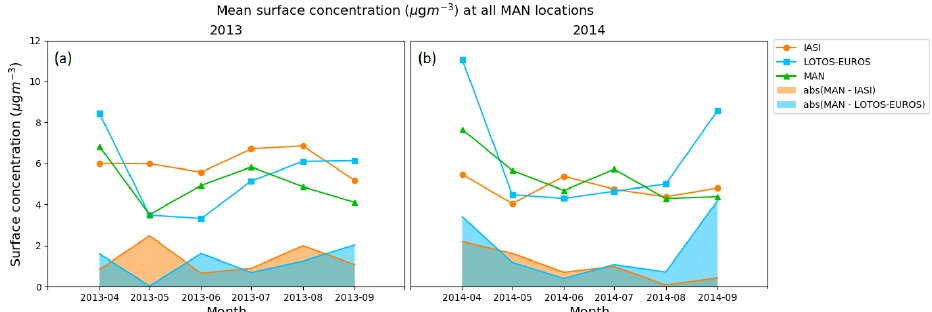
Figure 10. Mean of the NH 3 surface concentrations at all MAN locations per month (green line) and the coinciding NH 3 surface concen- trations from LOTOS-EUROS (blue line) and IASI (orange line) in 2013 (a) and 2014 (b) . The absolute differences between MAN and LOTOS-EUROS are shown in blue and the absolute differences between MAN and IASI are shown in orange.